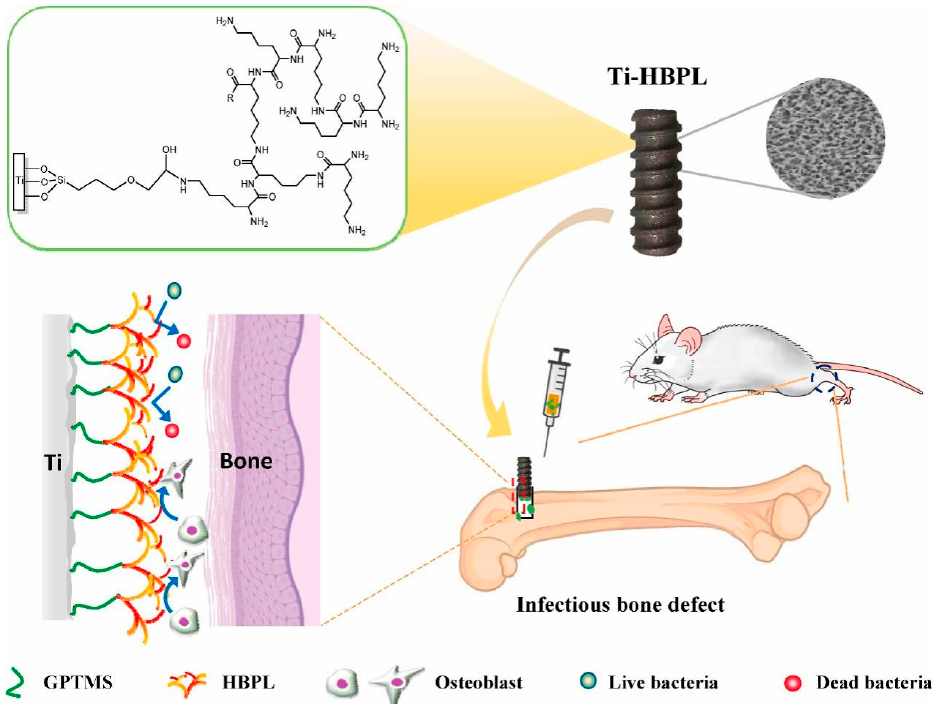
Figure 4. Schematic diagram showing the structure of the HBPL-modified implant rod, which combines the anti-infection and promoted osteogenesis in vivo. Hyperbranched poly-L-lysine (HBPL) polymers were covalently immobilized onto the alkali-heat treated titanium (Ti) substrates and implants by using 3-glycidyloxypropyltrimethoxysilane (GPTMS) as the coupling agent, which displayed outstanding anti-infection activity and better osseointegration in vivo. Reprinted with permission from ref. [141]. Copyright 2021 Elsevier.